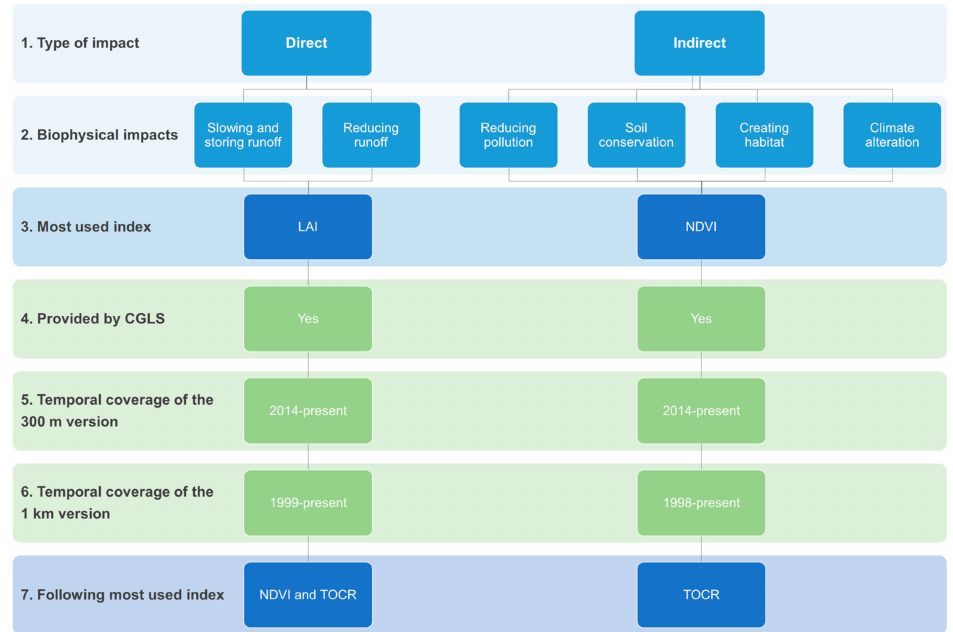
Figure A8. Decision flowchart indicating the most suitable indices available in the Copernicus Global Land Service for the monitoring of NWRM biophysical